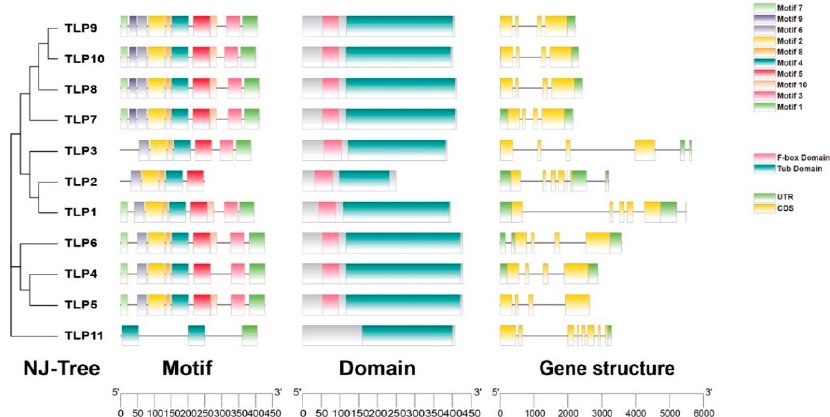
Figure 2. The Motif, domain, and gene structure of TLPs in tomato.